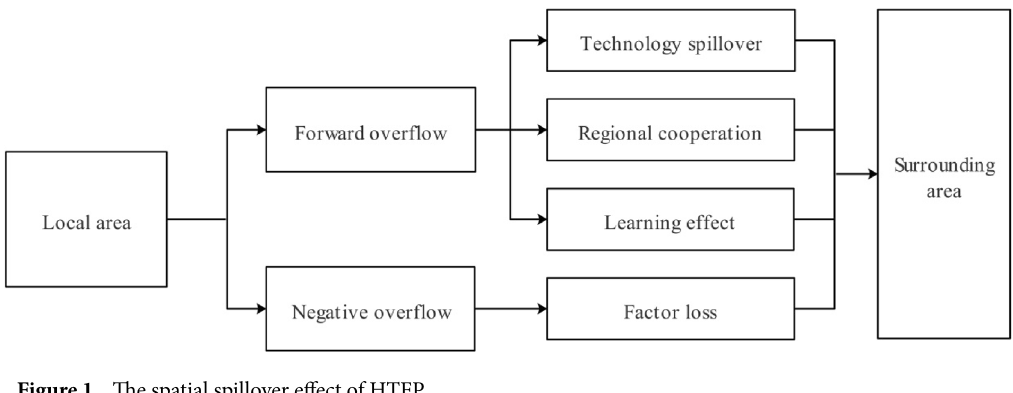
Figure 1. The spatial spillover effect of